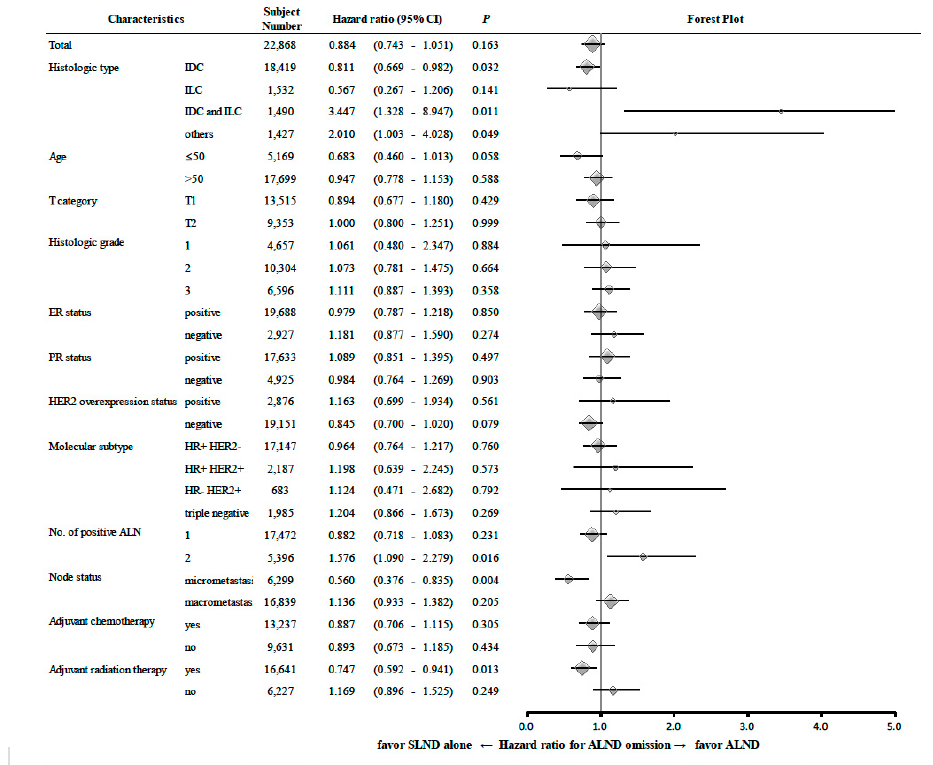
Figure 2. Risk of breast cancer-specific mortality in each subgroup of the Z0011-comparable patients according to the clinicopathologic risk factors. Abbreviations: axillary lymph node (ALN); axillary lymph node dissection (ALND); confidence interval (CI); estrogen receptor (ER); human epidermal growth factor receptor 2 (HER2); hazard ratio (HR); invasive ductal carcinoma (IDC); invasive lobular carcinoma (ILC); progesterone receptor (PR).